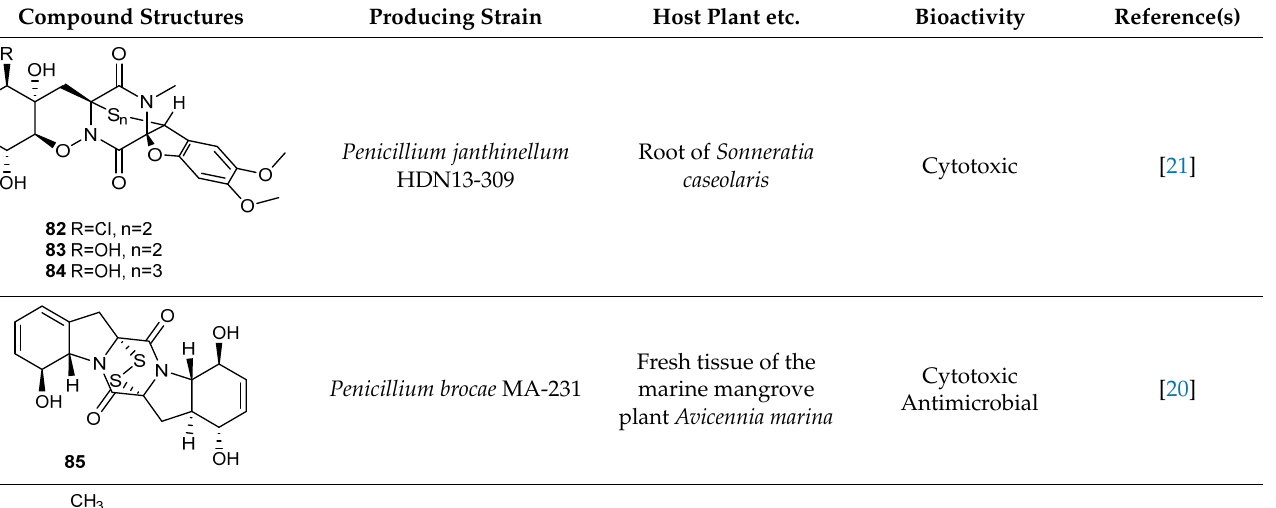
Table 1. Cont . Compound Structures Producing Strain Host Plant